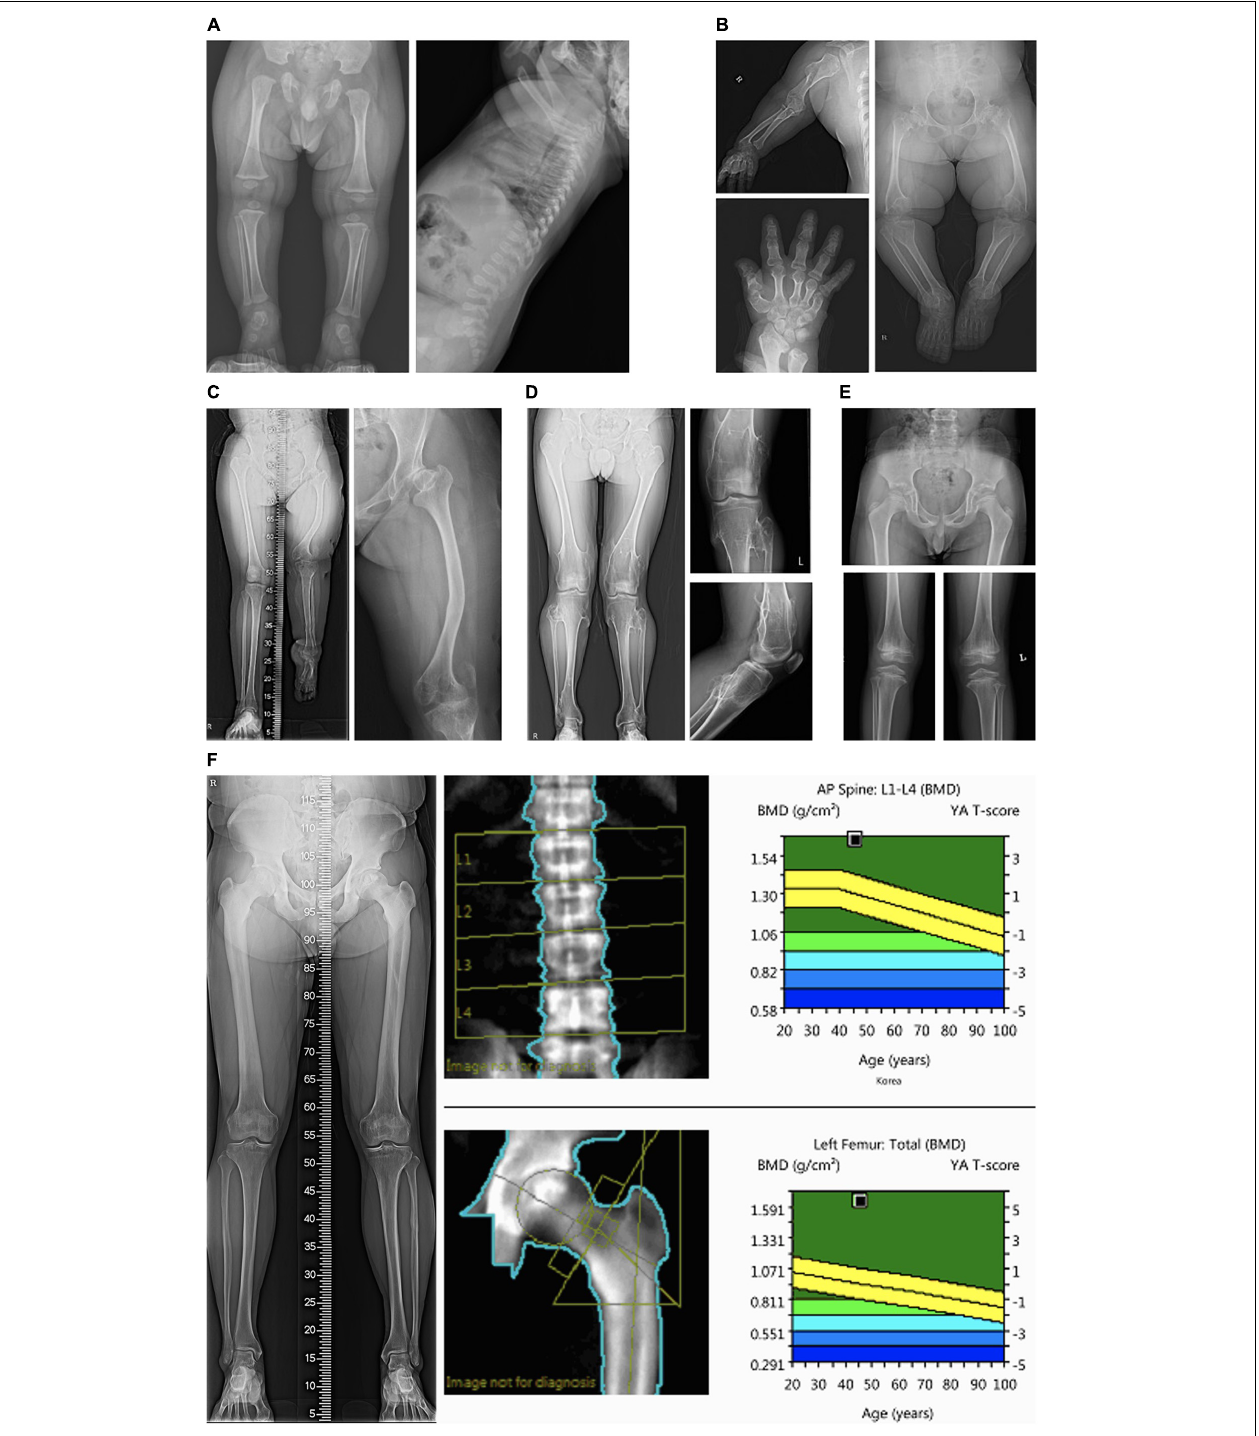
FIGURE 1 | Representative skeletal survey images of patients in categories 1 and 2. (A) Radiographic images of case #1 with type II collagenopathy (spondyloepiphyseal dysplasia congenita) showing horizontal acetabuli of the pelvic bone and a pear-shaped lumbar vertebral body at 8 months of age; (B) Case #3 with pseudoachondroplasia showing dysplastic and relatively short upper and lower extremity bones. Bilateral femur heads are flattened and both acetabuli show degenerative changes; (C) case #5 with X-linked dominant chondrodysplasia punctata showing shortening and bowing of the left femur, dysplastic hips; (D) case #6 with multiple cartilaginous exostoses showing multiple exostoses in the bilateral distal femur and proximal tibia; (E) case #8 with multiple epiphyseal dysplasia showing small and dysplastic both proximal femoral epiphyses and acetabular dysplasia. Both knees show epiphyseal and metaphyseal irregularity; (F) Case #10 with osteopetrosis showing increased cortical bone thickness. The bone densitometry T-scores of the spine and femur were 3.5 and 5.2, respectively.